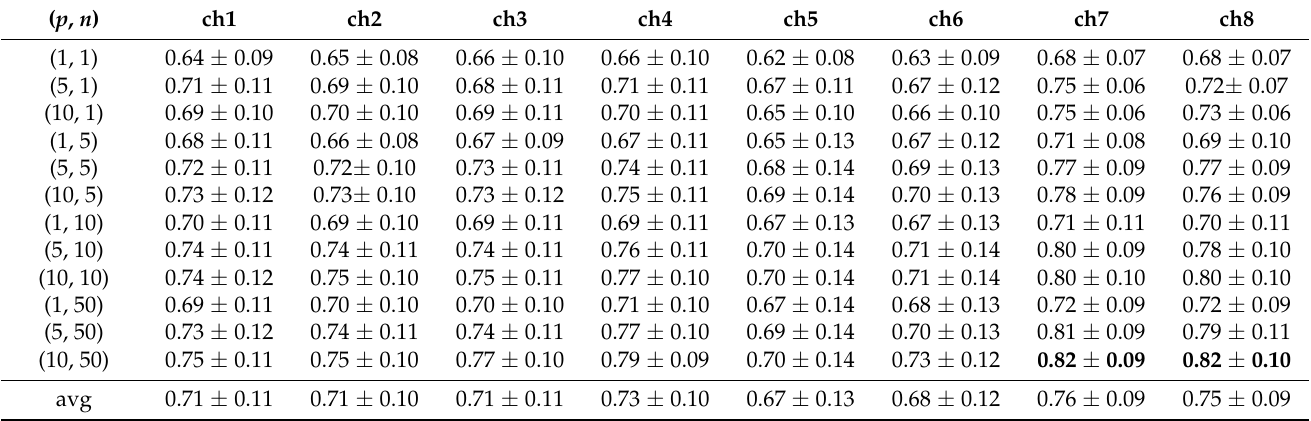
Table 2. A3S-Rec dataset: AUPRC of the 10-way 10-shot SWC prototypical model tested on individual recordings for each acquisition